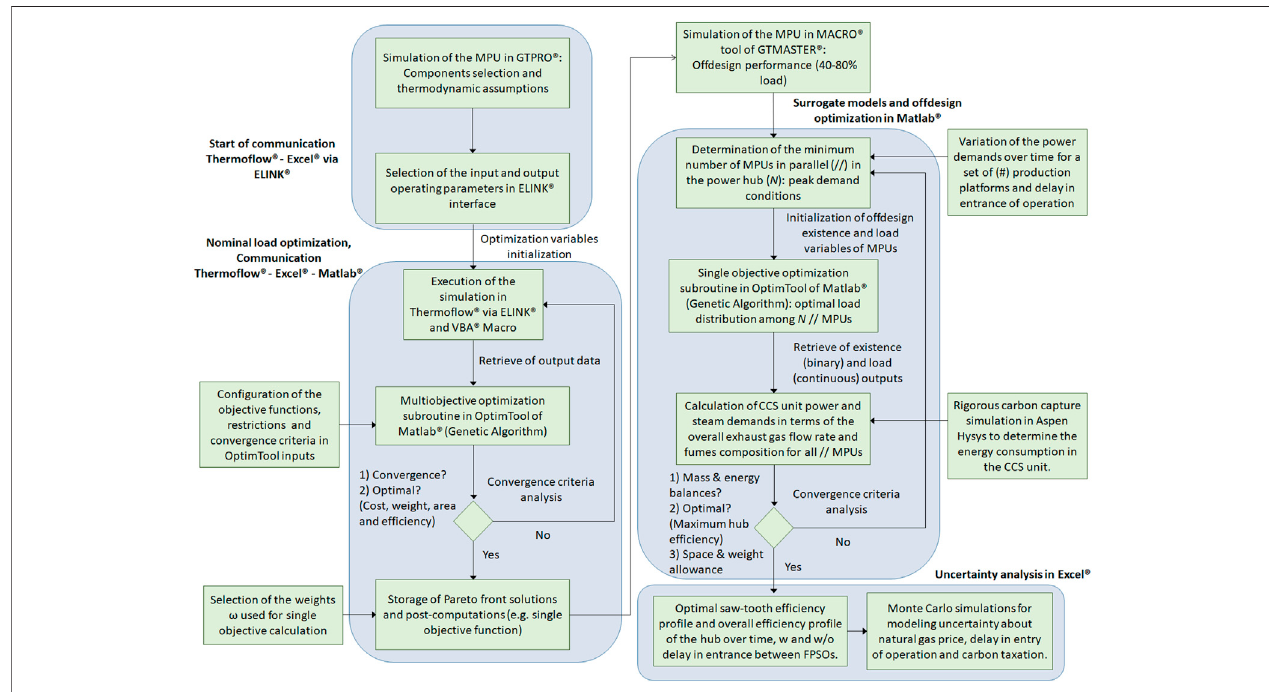
FIGURE 4 | Flow diagram of the process synthesis and optimization of the power hubs based on the use of Thermo fl ow, Matlab, Excel and Aspen Hysys.